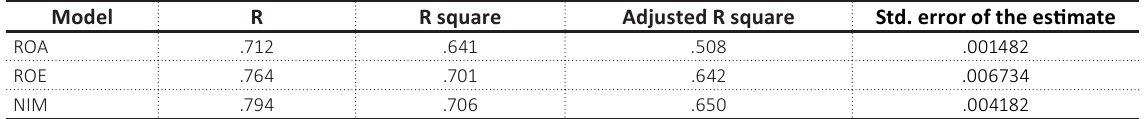
Source: Analytical data from SPSS 20.